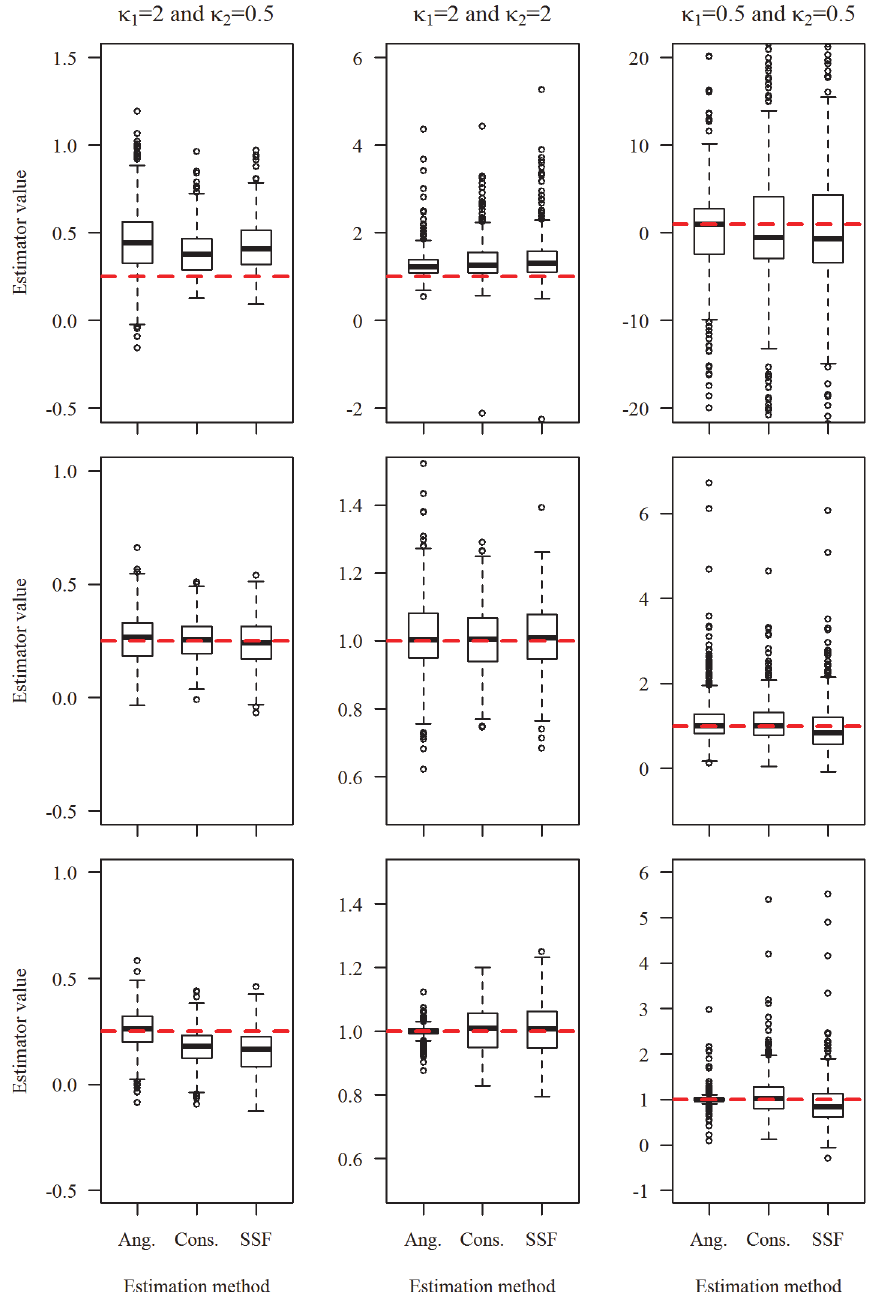
Fig 1. Comparison of the three estimators of β = κ 2 / κ 1 for 9 simulation scenarios. Each boxplot summarizes values of the estimates of parameters β = κ 2 / κ 1 that were obtained with the angular (Ang.), consensus (Cons.) and empirical SSF (SSF) estimation methods from 500 simulations under the discrete choice model (row 1), the consensus simulation model (row 2), and the angular simulation model (row 3). The red horizontal dashed line indicates the true parameter